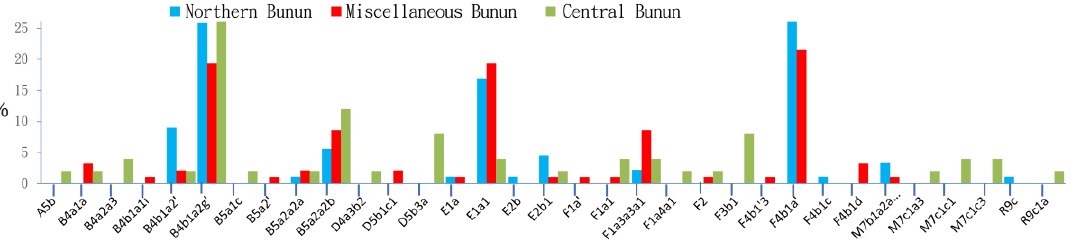
Figure 2. MtDNA comparison of the three Bunun groups: Northern Bunun (Blue), Miscellaneous Bunun (Orange), and Central Bunun (Grey) [33].